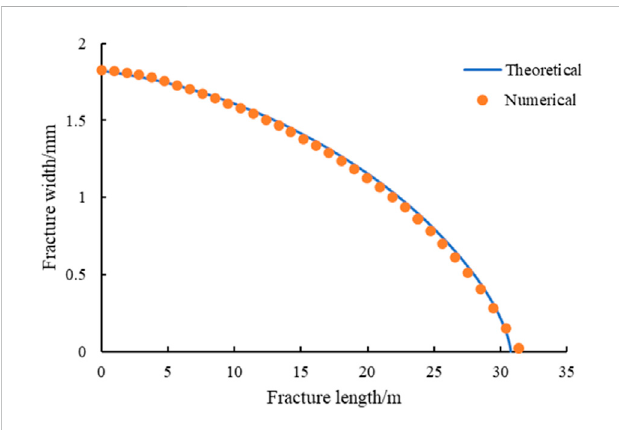
FIGURE 2 Comparison between the theoretical solution and the numerical solution for hydraulic fracture width versus fracture position.